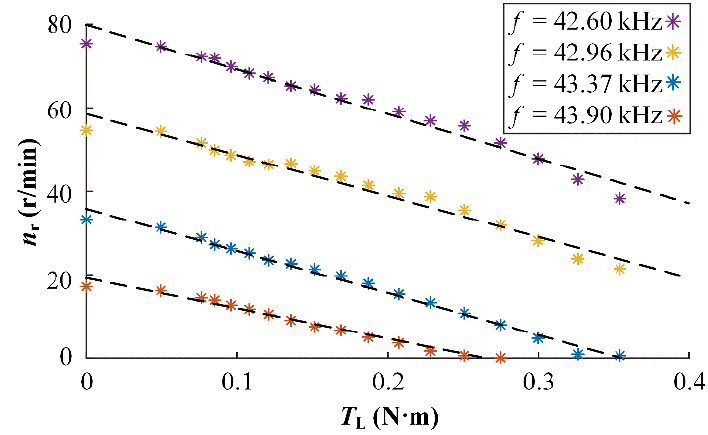
Figure 2. Rotor revolving speed vs. load at constant input.